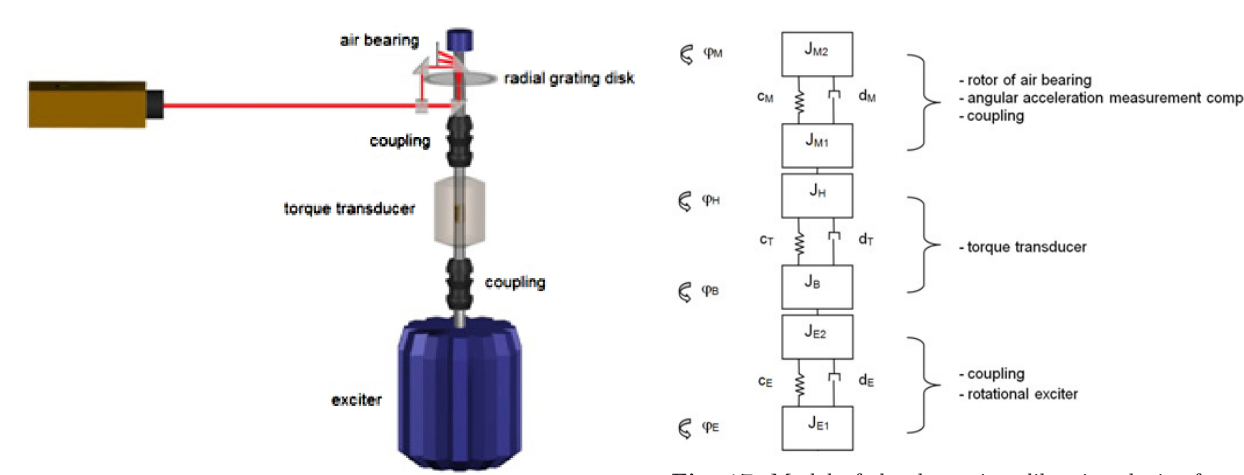
Fig. 16. Schematic representation of a dynamic torque cali- bration device [10].